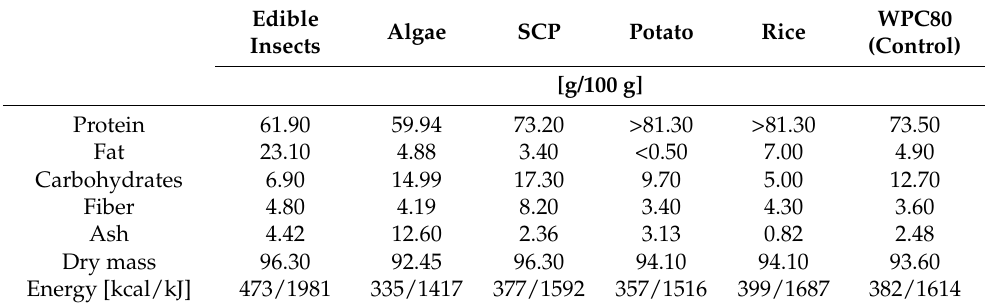
Table 1. Nutritional value of alternative and unconventional protein sources compared to the whey protein concentrate (WPC80—control